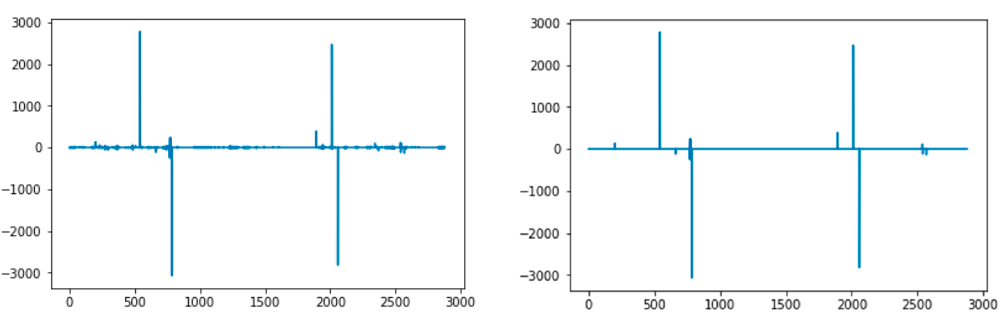
Figure 16. DEM skyline ( left ) and its depth ( right ).